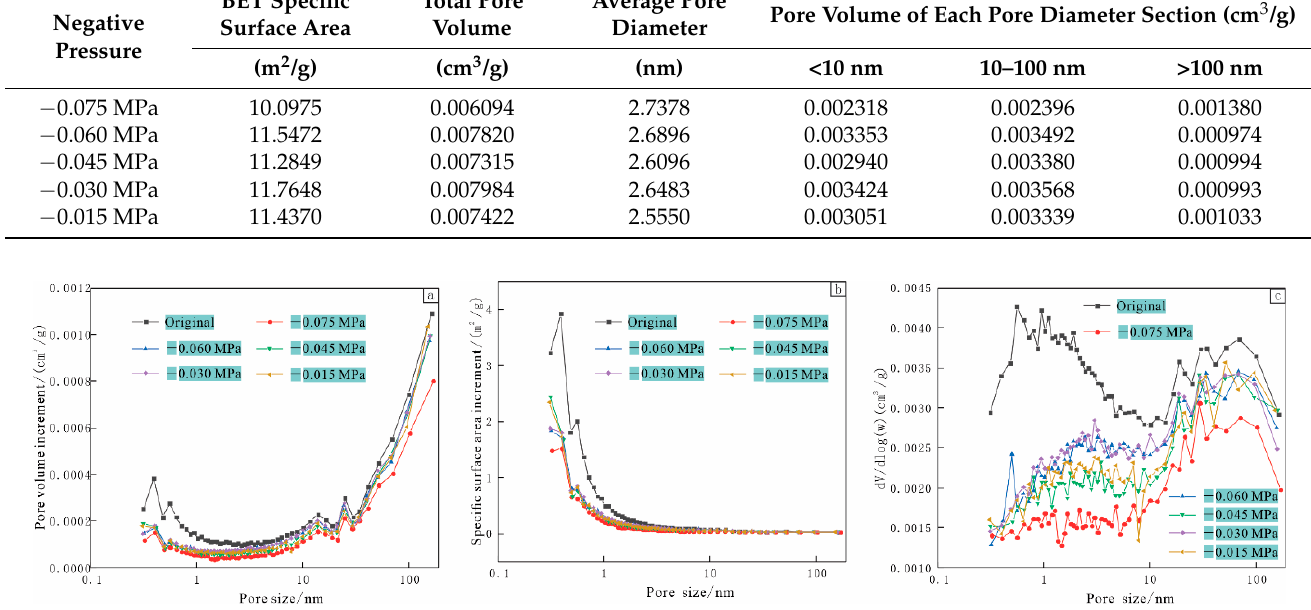
Table 3. Experimental results of the LT-N 2 A on the low-rank coal samples under negative pres- sure.